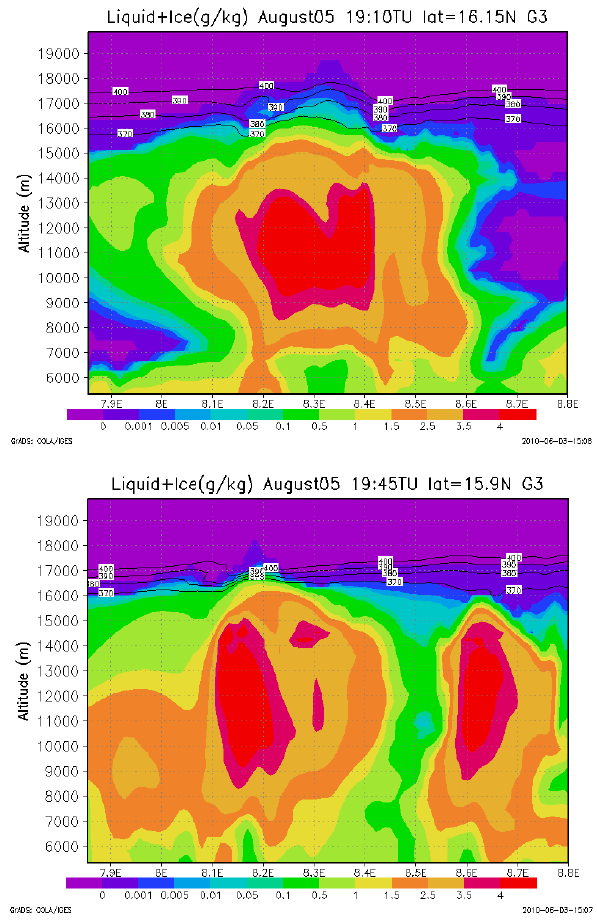
Fig. 12b Fig. 12. Grid 3 vertical cross-section of condensed water (gkg − 1 ) for the A¨ır case BRAMS simulation. Isentropic levels are also shown. (a) Longitude/Altitude vertical cross-section at 16.15 ◦ E latitude, at 19:10UT. (b) Longitude/Altitude vertical cross-section at 15.9 ◦ E latitude, at